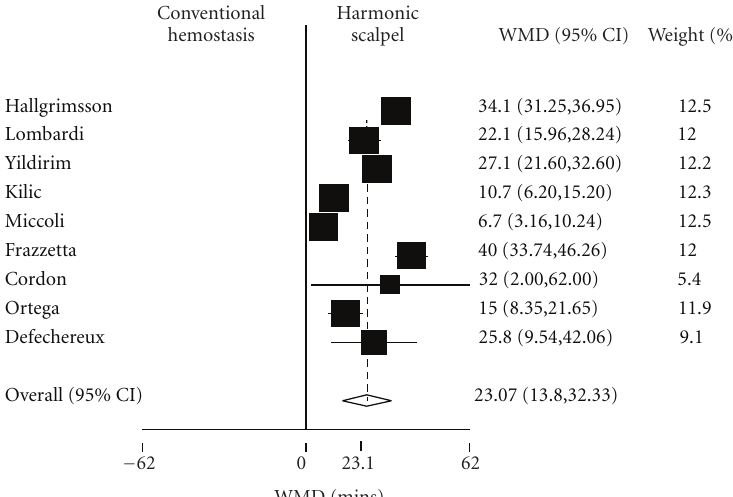
Figure 2: Forest plot depicting individual and pooled weighted mean di ff erence (WMD) in operative times with 95% confidence intervals.